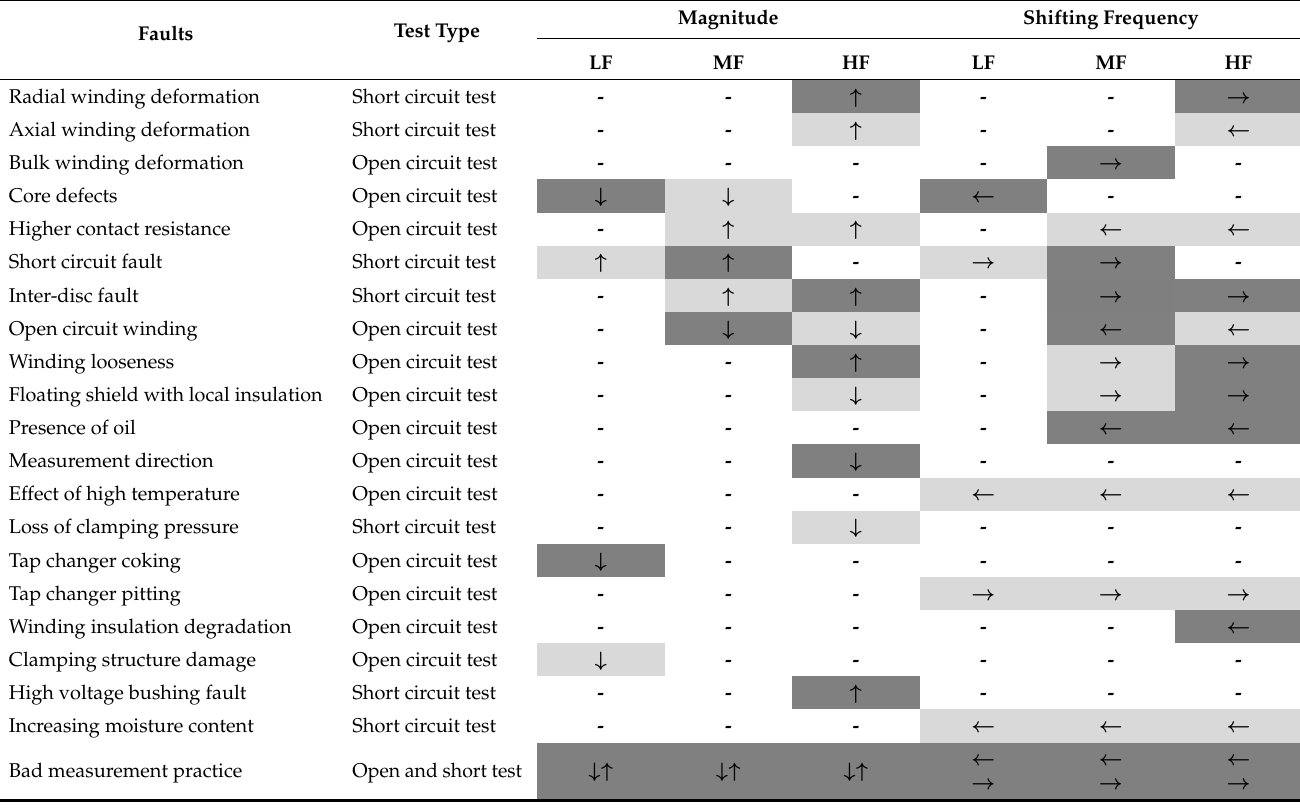
Table 4. Characteristics of FRA signature due to transformer faults.